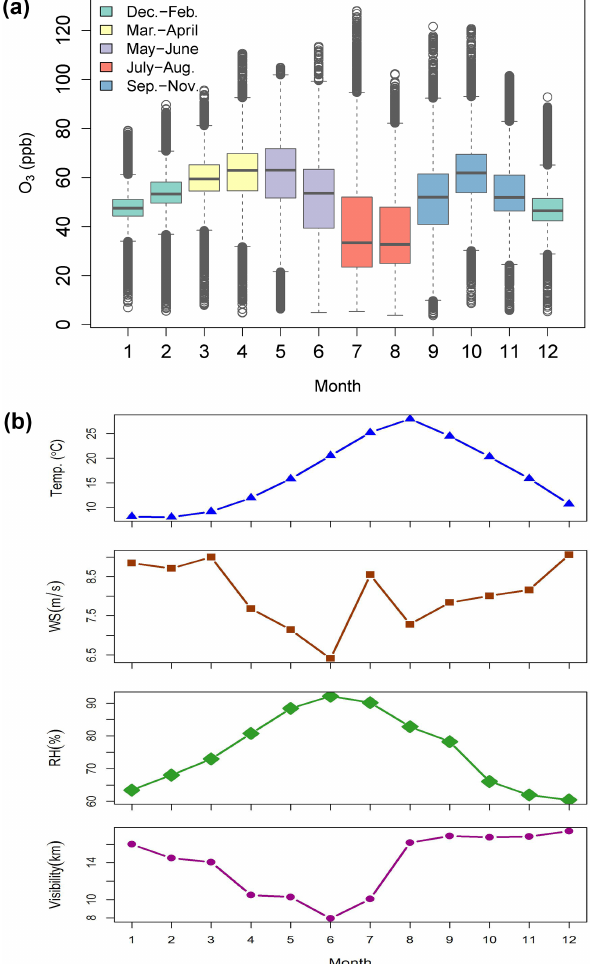
Figure 4. (a) Monthly variations of O 3 presented with median, in- terquartile range (IQR), 1.5IQR, and outliers, and (b) monthly dis- tributions of temperature, relative humidity, wind speed, and visi- bility at